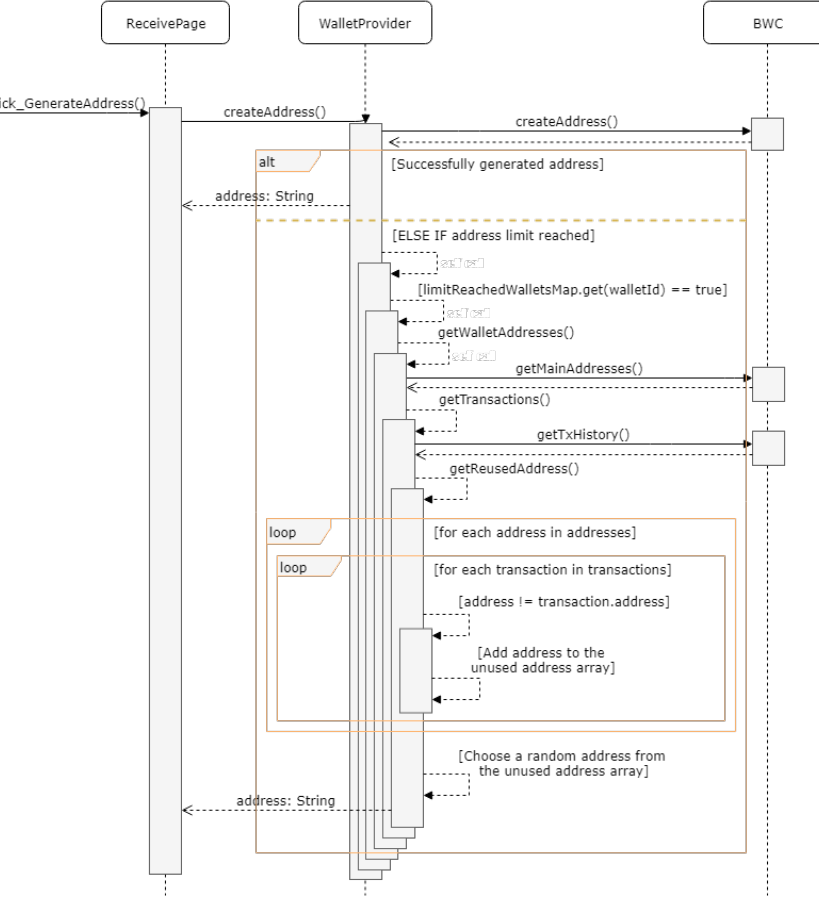
Figure 6. Sequence diagram of the algorithm for address reuse.